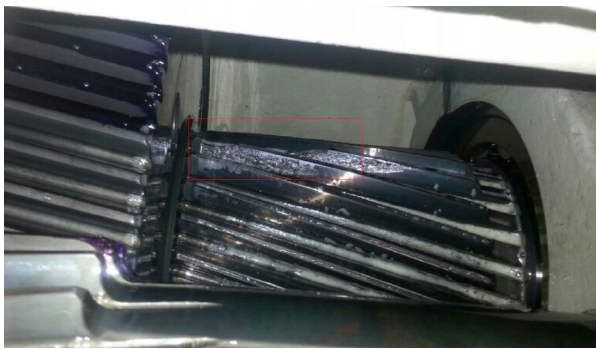
Figure 10. Chipped pinion on intermediate shaft of a wind turbine gearbox. Compared with the vibration signal of the faulty gear on the intermediate shaft, the shocks of the faulty pinion on the high-speed shaft in Figure 12a perform more intensive due to the higher rotational speed of the high-speed shaft. Figure 12b is the Fourier spectrum of the vibration signal in Figure 12a, showing multiple harmonics of the rotational frequency of the high-speed shaft. Figure 12c is the all-pass envelope spectrum of the vibration signal, where clear rotational frequencies of the high-speed shaft are displayed. The broken pinion on the high-speed shaft corresponding with the vibration signal in Figure 12 is shown in Figure